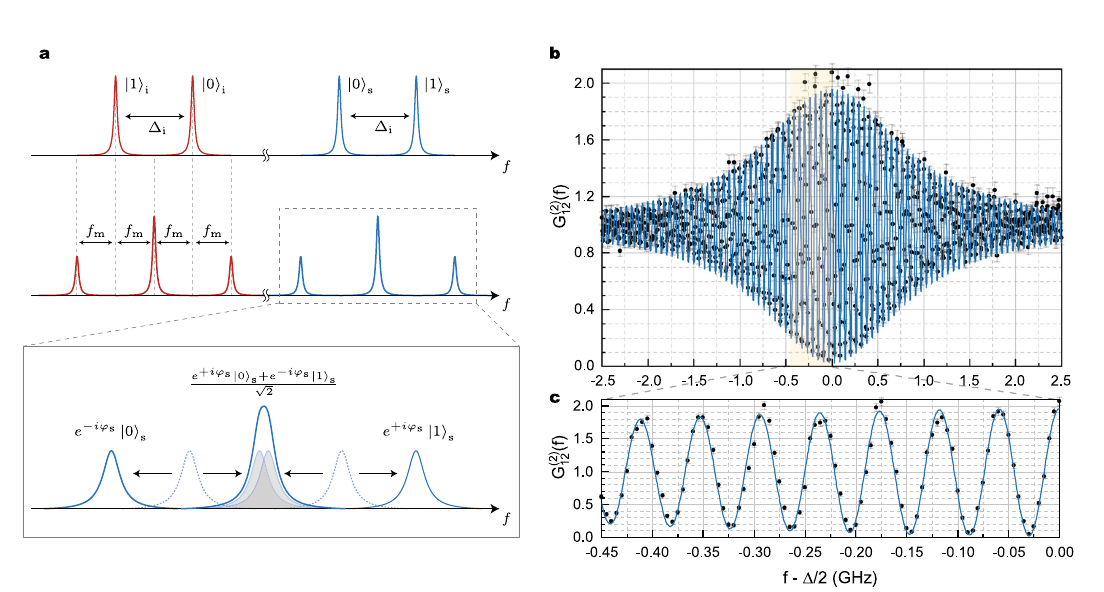
f Δ /2,whenperfectindistinguishabilityofthegeneratedbinsisachieved. b Two- m = photon correlation G ð 2 Þ 1,2 of the frequency-mixed bins as a function of the detuning − Δ /2. The experimental points (black dots) were obtained by counting coin- f m cidences between frequency-mixed bins at varying modulation frequency, while keeping fi xed the modulation phase, and normalizing. Error bars (light gray) were estimated assuming Poissonian statistics. Blue curve represents the best- fi t of the curve according with Eq. (2), showing good agreement ( c ) with theoretical